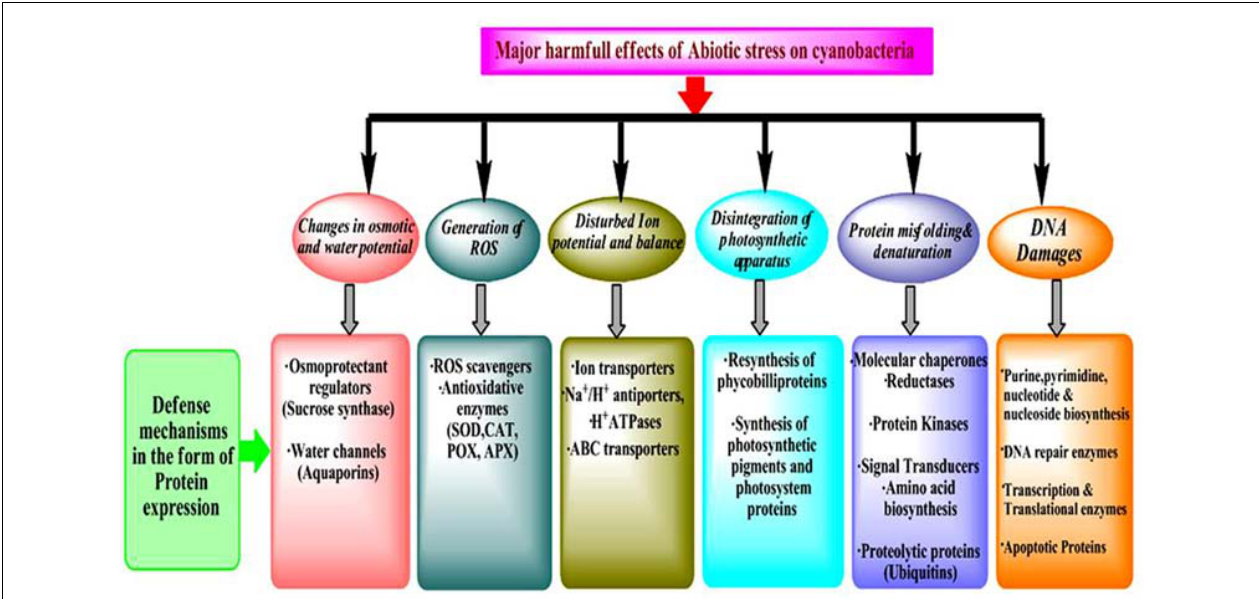
FIGURE 1 | Categorization of proteins expressed at different molecular level against abiotic